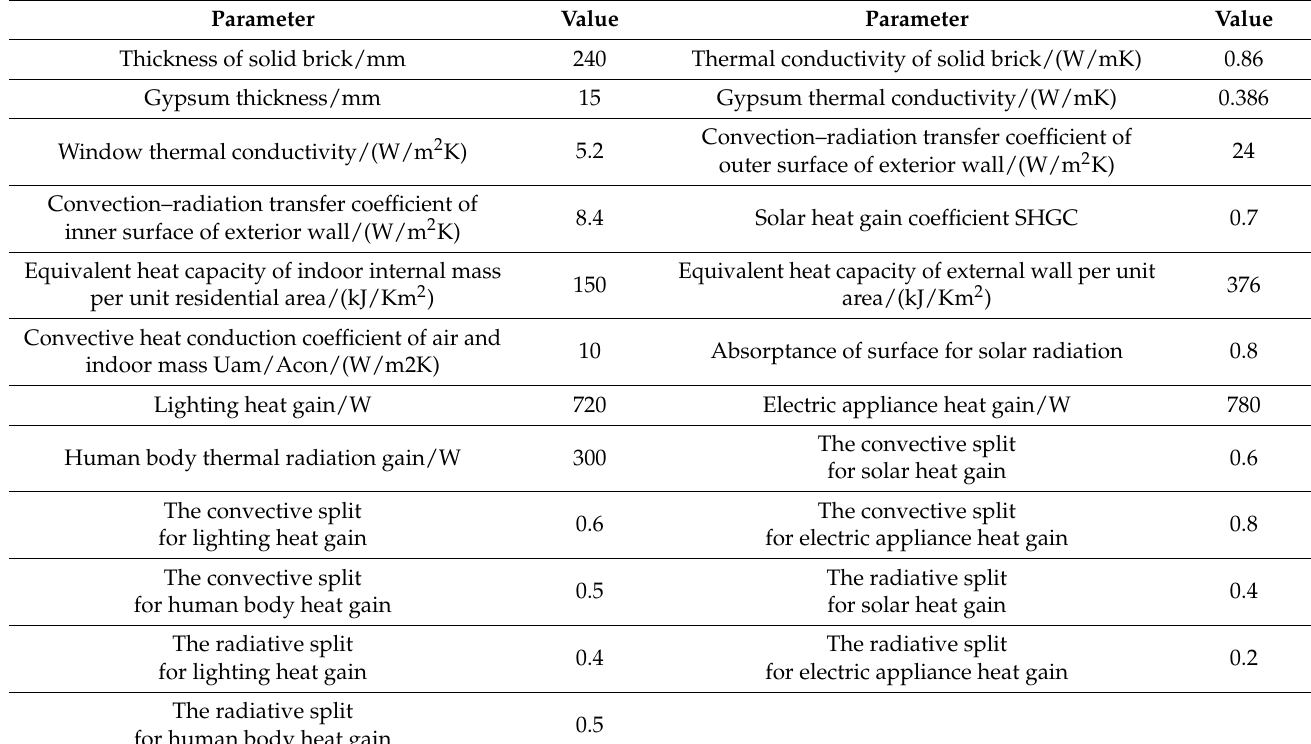
Figure 1. Research architecture. Table 1. The parameters of the room thermal